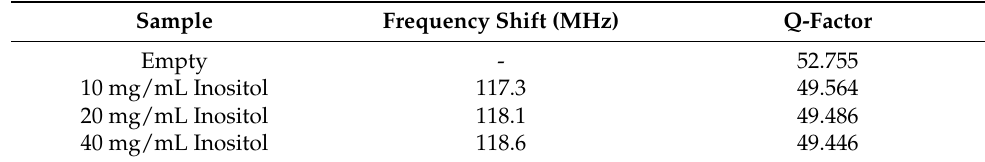
Figure 15. Measured transmission responses of different concentration of inositol solution. Table 9. The frequency shift and Q-factor of different concentration of inositol solution.